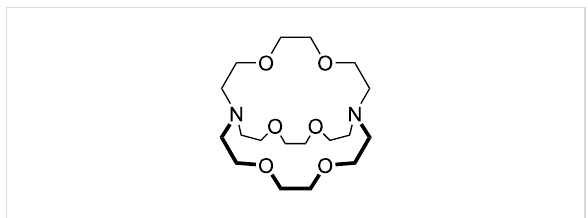
Figure 1: Structure of [2.2.2] also known as 4,7,13,16,21,24-hexaoxa- 1,10-diazabicyclo[8.8.8]hexacosane or Kryptofix 222.